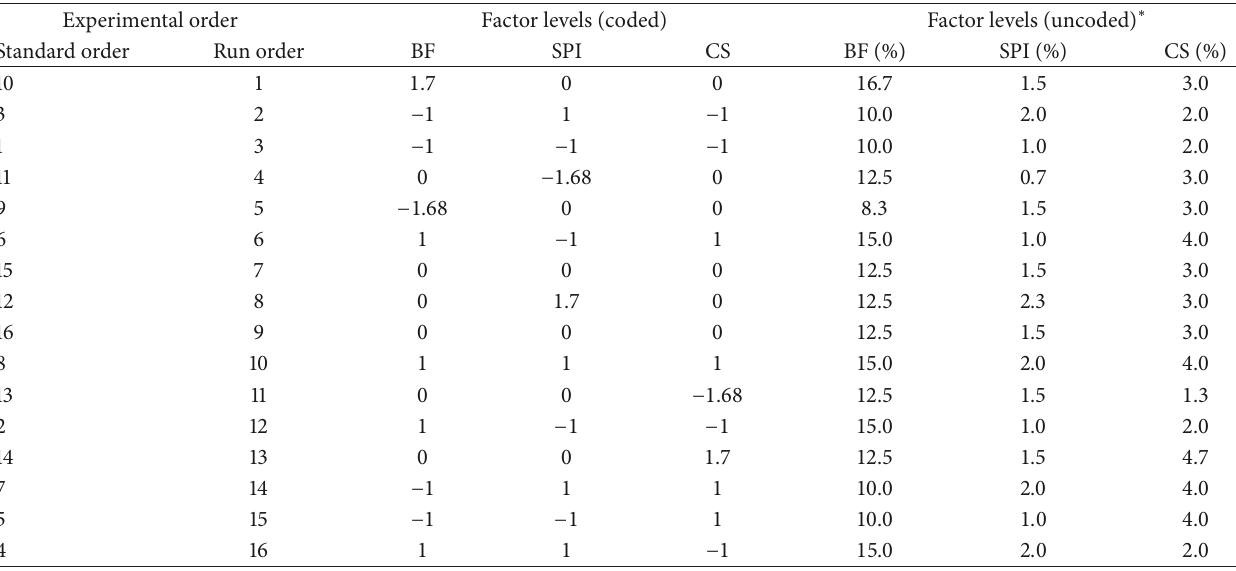
Table1:Mixturedesignofbrisketfat,soyproteinisolate,andcornstarchtoevaluatetheeffectsofprocessvariablesandexperimentalresponses for nutritional and textural properties of rabbit